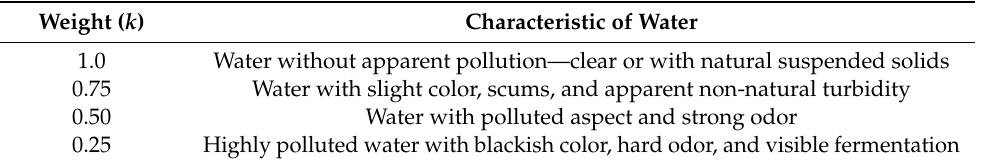
Table 1. Weight classification according to organoleptic characteristics of